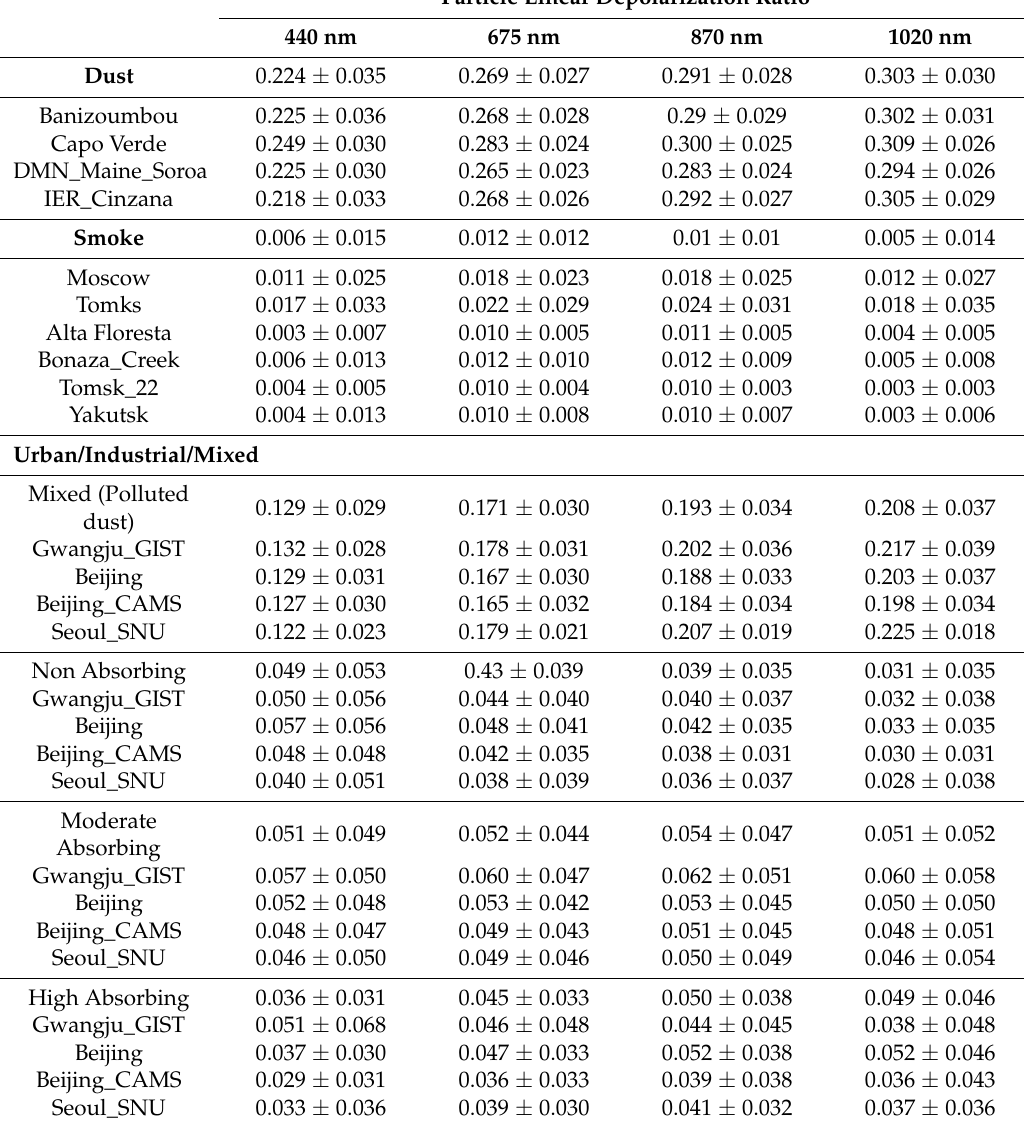
Table 3. Spectral mean particle linear depolarization ratio ( δ p ) from the AERONET Version 3 Level 2 inversion product at each representative aerosol source